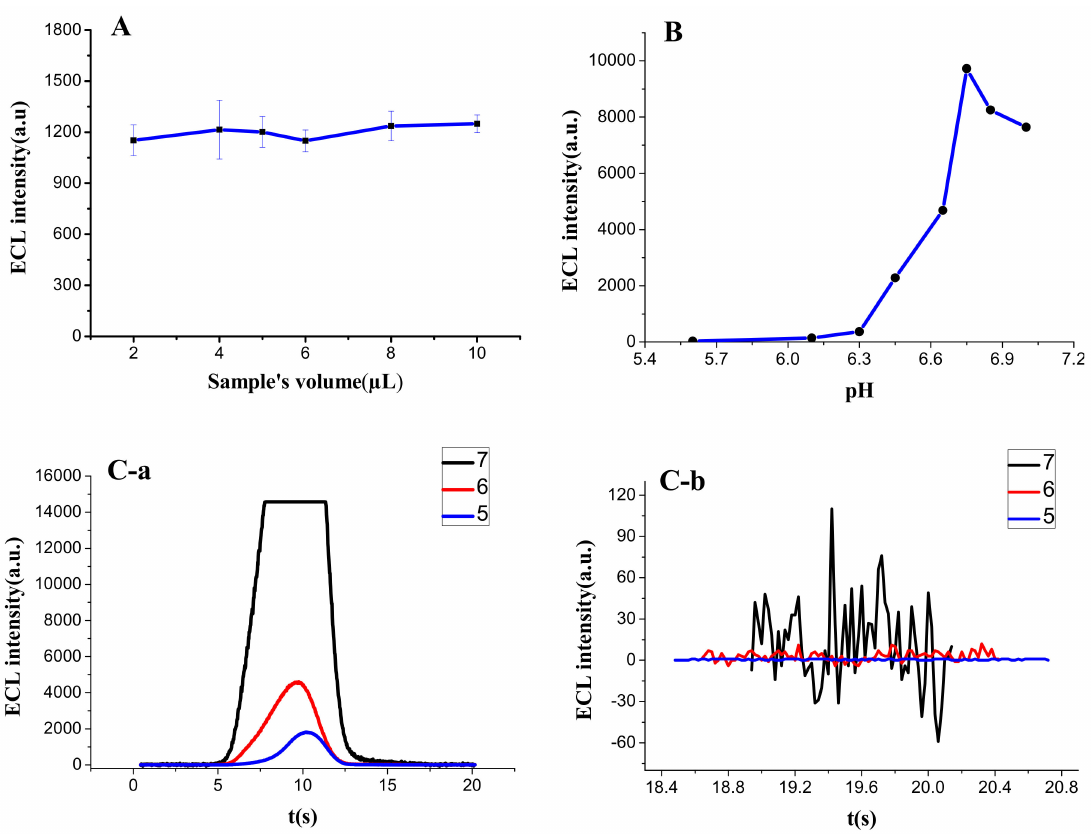
Figure 4. The effect of different factors on ECL intensity: ( A ) the effect of additive amount of sample on ECL intensity; ( B ) the effect of sample’s pH on ECL intensity; ( C ) the ECL intensity ( C-a ) and noise ( C-b ) of sample in different multiplier series of